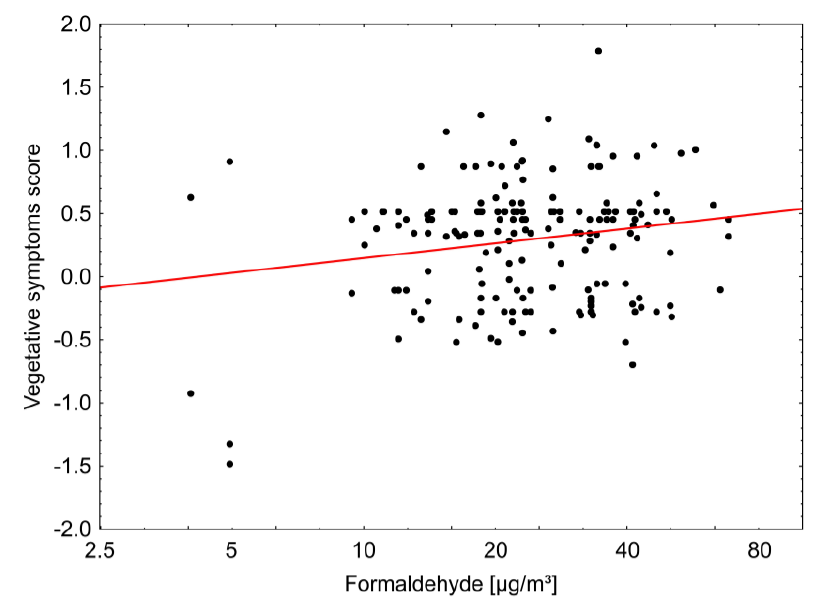
Figure 1. Correlation between indoor concentration of formaldehyde and frequency of vegetative symptoms (dizziness, nausea, headaches; standardized score) at T2 (about 1.3 years after moving in) (R 2 = 2.3%).